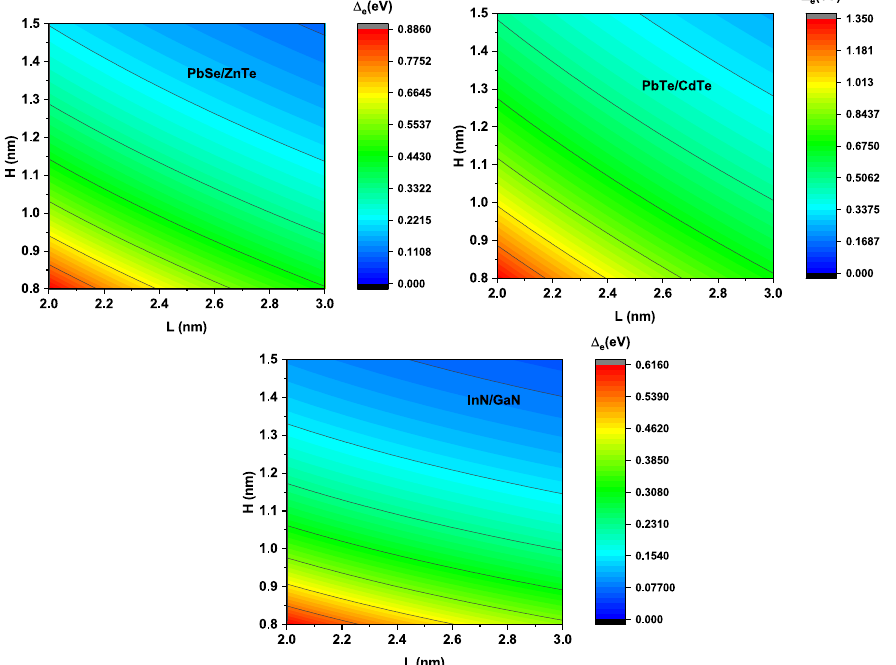
Figure 3. A 2D contour plot of IB electron width as function, the dot size L and inter-dot distance H for different system